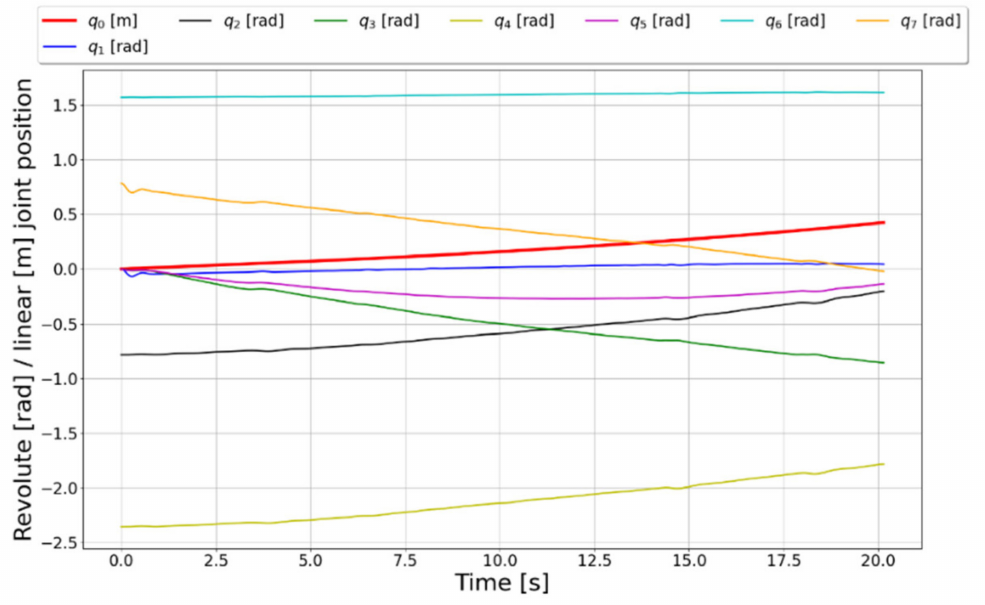
Figure 10. Joint position trajectories of the 8-DoF robot assistant during the execution of a linear trajectory along the Y - axis